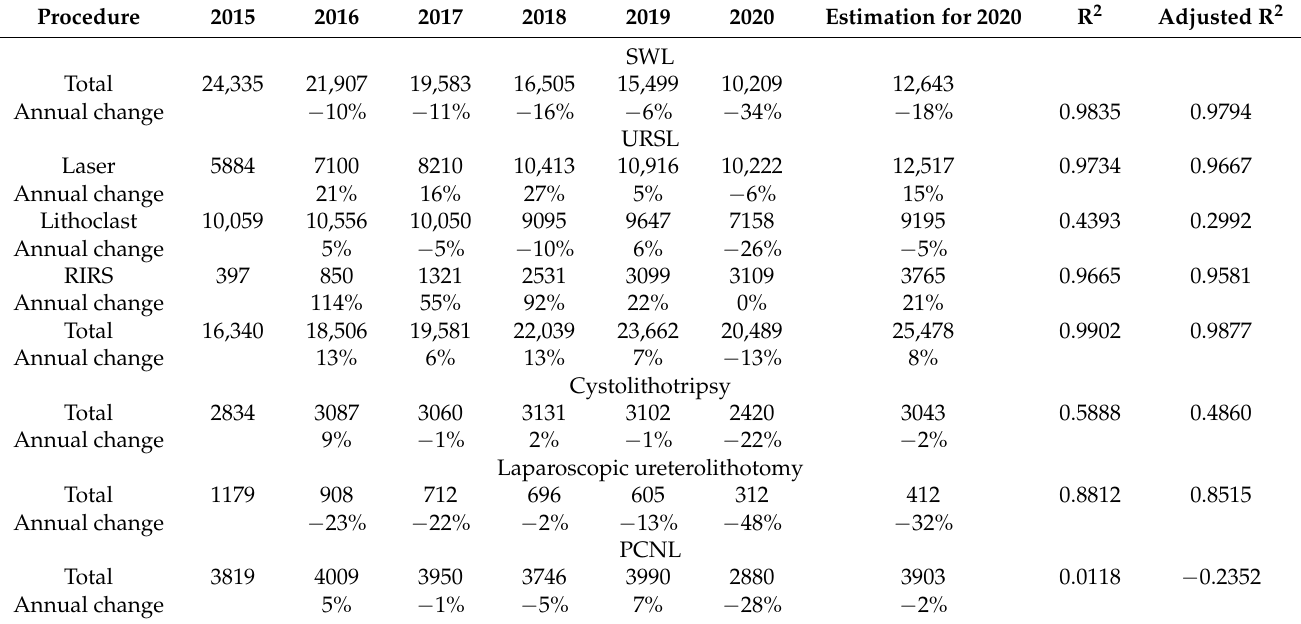
Table 2. Urolithiasis procedures registered in 2015 to 2020 and expected values for 2020.